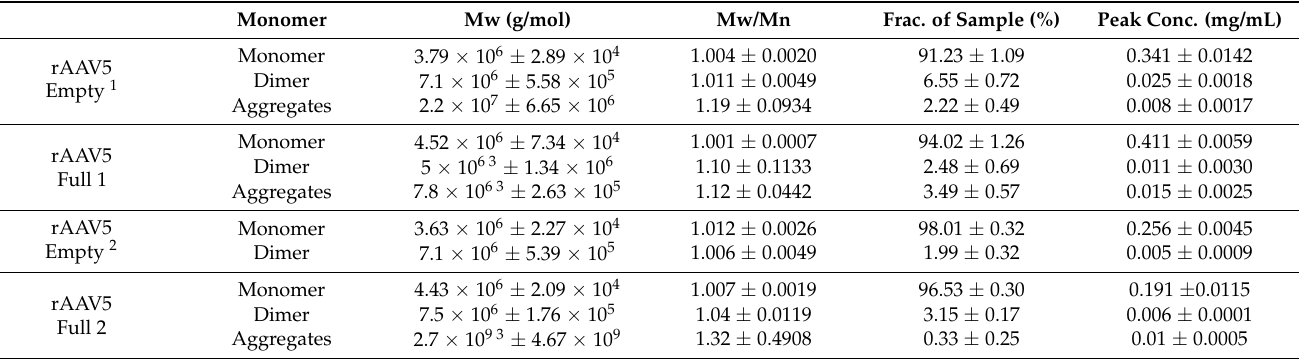
Table 5. Population data for rAAV5 empty and full by SEC-SLS. Batch 1 1 and Batch 2 2 were analyzed using different columns.